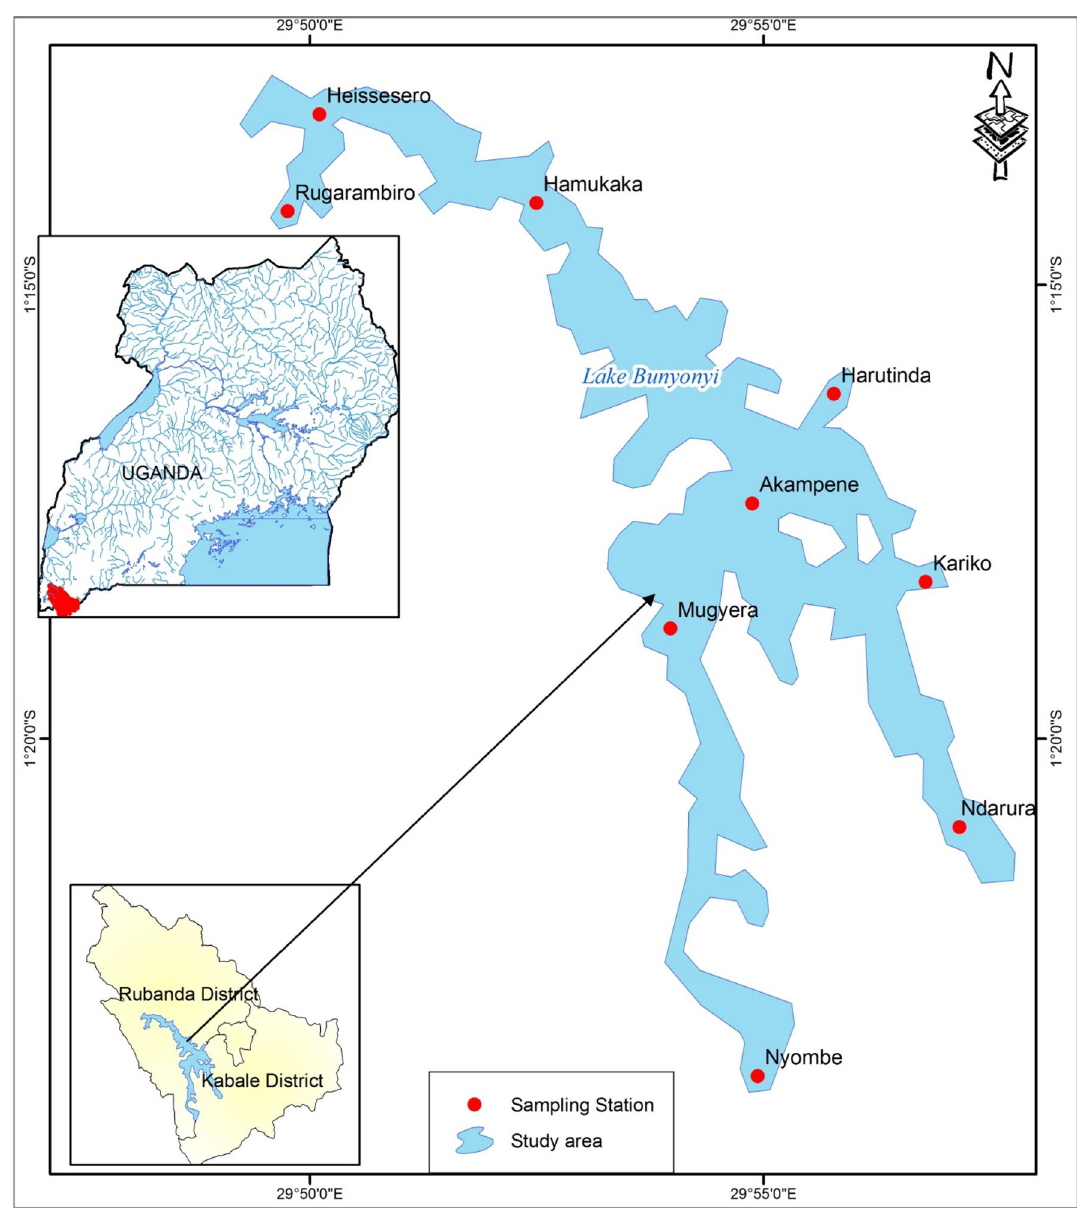
Fig. 1 Location Map of Lake Bunyonyi, Southwestern